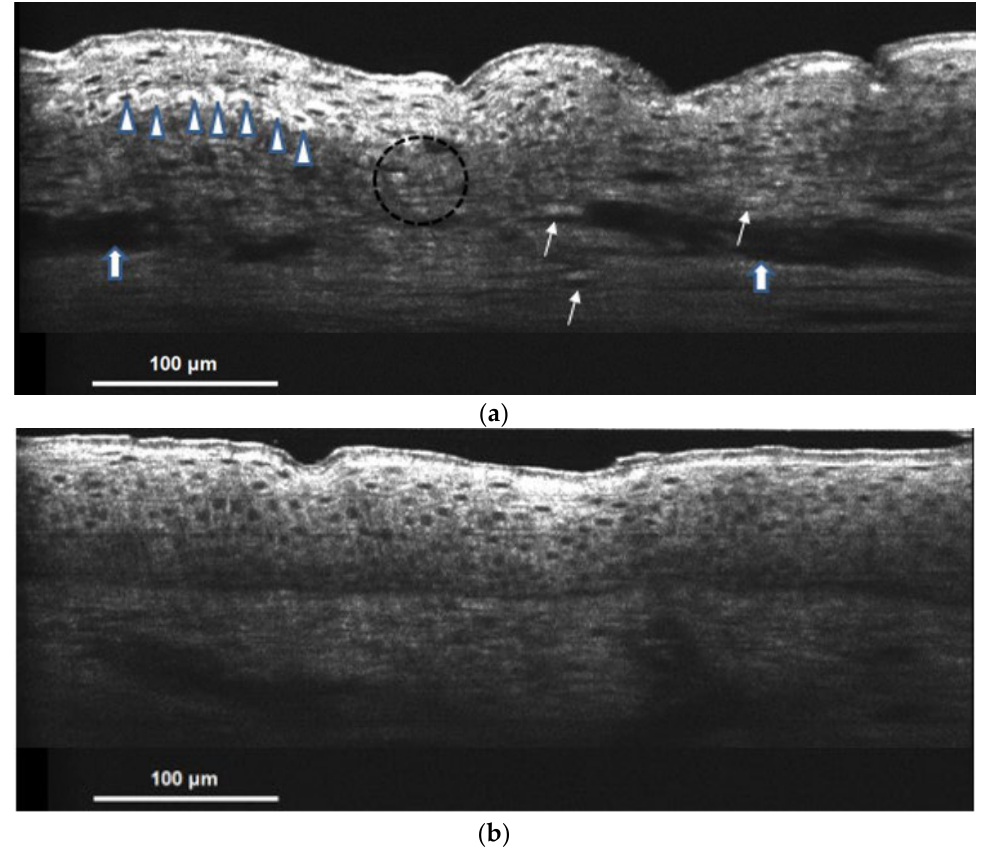
Figure 5. ( a ) Hyperpigmented lesional skin of Riehl’s melanosis on cellular resolution OCT. Hyper- reflective supranuclear capping is presented (shown in ). Spotty donut shape and hyper-reflective melanophages can also be observed in the dermis (shown in the arrow). Blurred DEJ represents basal keratinocyte degeneration (shown in a circle). Irregular acanthosis and vessel dilatation with increased blood flow (shown in ) are the signs of dermal inflammation; ( b ) hypopigmented le- sional skin of Riehl’s melanosis on cellular resolution OCT showed nearly no melanin capping nor dermal melanophages and resembled normal skin.